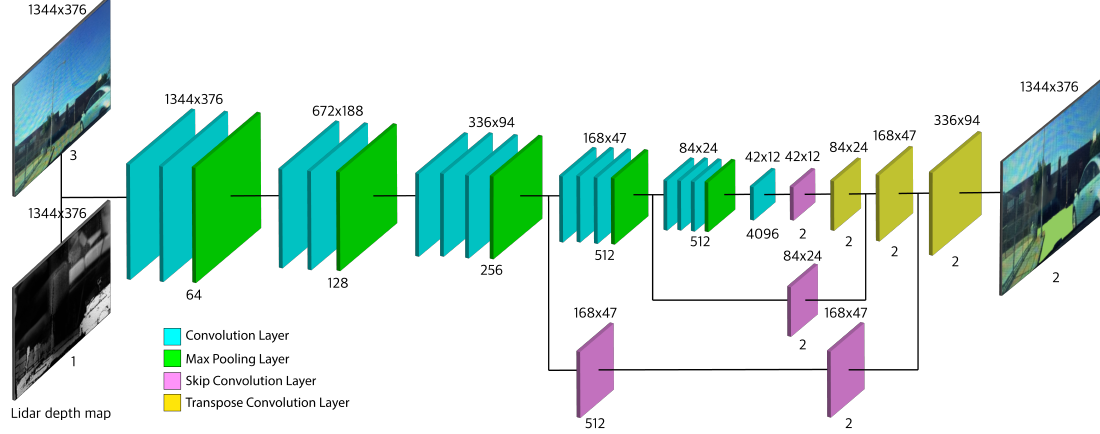
Figure 8. Overview of the object detection and road segmentation architecture via a Fully Convolutional Neural Network. The tiles and colors indicate different layers of the FCNx and their type respectively. Encoder consists of: convolution (teal) and max pooling (green) layers. Decoder consists of: skip convolution (purple) and transposed convolution (yellow). The size and number of feature maps are shown at the top and bottom of each